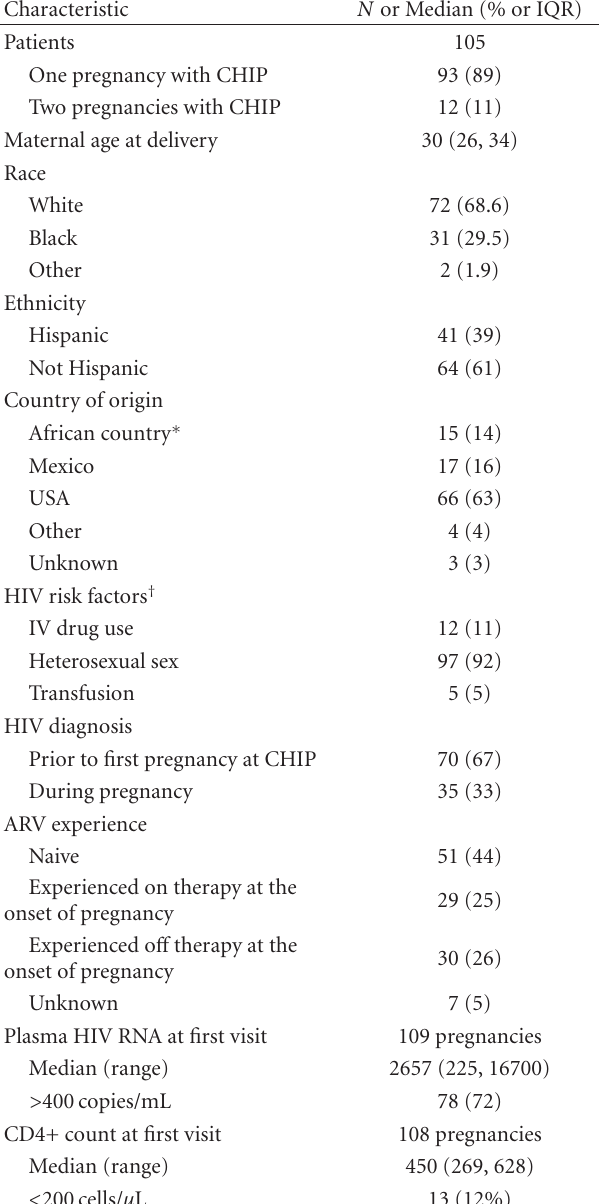
Table 1: Demographics and baseline characteristics of HIV infec- tion.